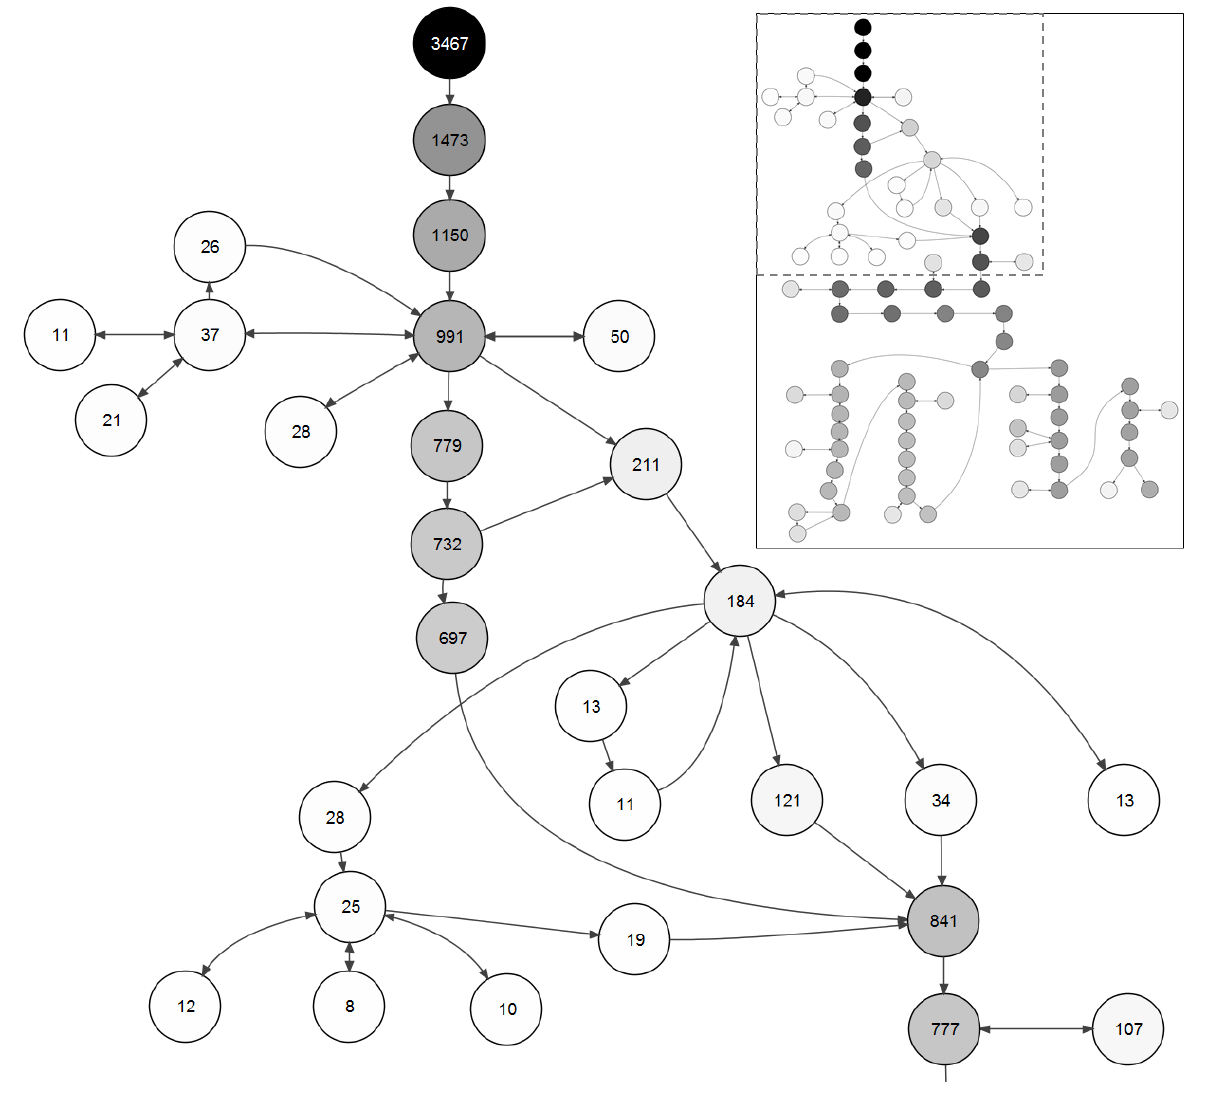
Figure 6. Number of visitors in screen cards of week 2 virtual patient.